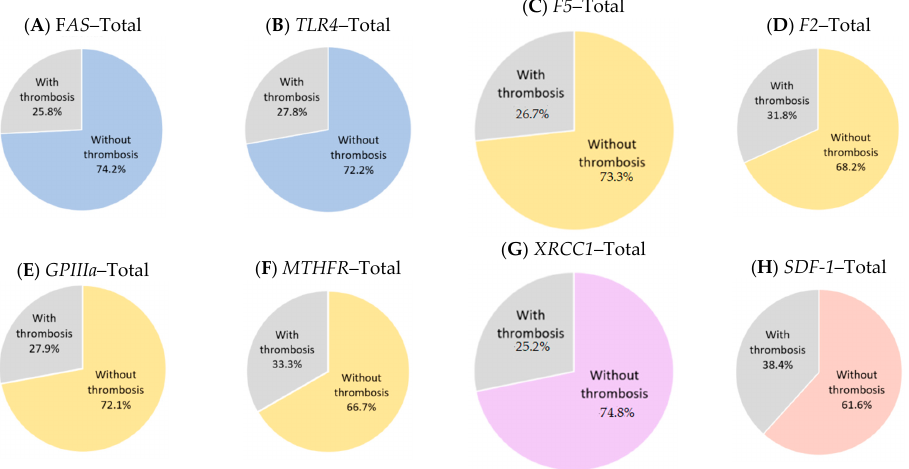
Figure 3. Thrombotic MPN patients with different gene polymorphisms. ( A , B ) Receptors. ( C – F ) Thrombophilic genetic factors. ( G ) DNA repair. ( H ) Chemokine. Abbreviations: F2 : Factor II, F5 : Factor 5, FAS : Fas cell surface death receptor, GPIIIa : Glycoprotein IIIa, MTHFR : Methylenetetra- hydrofolate reductase, SDF-1 : Stromal cell-derived factor-1, TLR4 : Toll-like receptor 4, XRCC1 : X-ray repair cross complementing 1.